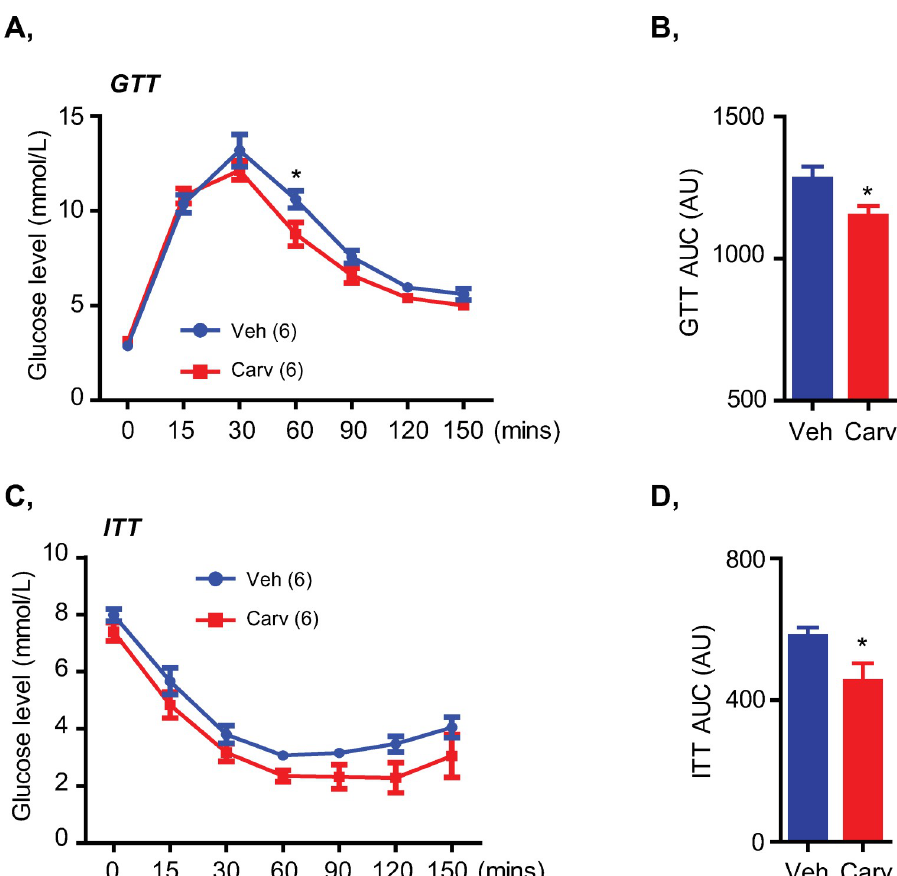
Fig 4. Carvedilol treatment targeting the adrenergic overactivation in HFD-fed mice improved glucose tolerance and insulin sensitivity. A, B, GTT (A) and GTT AUC (B) of HFD-fed mice treated with vehicle or carvedilol. C, D, ITT (C) and ITT AUC (D) of mice. Data are presented as mean ± S.E.M. Student’s t-tests in bar graphs and two-way ANOVA with Bonferroni’s post-tests in line graphs. � P < 0.05.